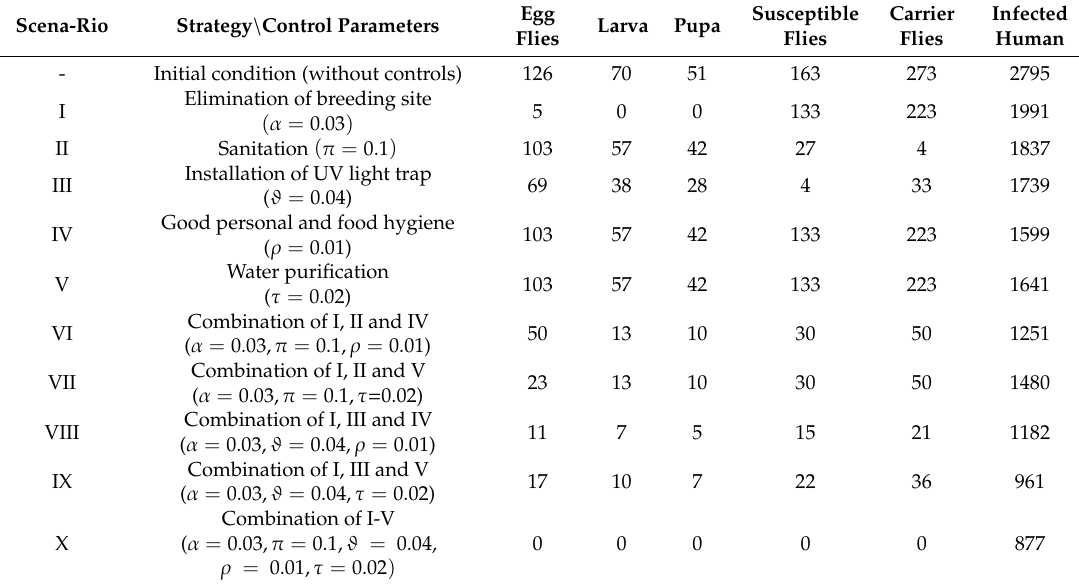
Table 5. Scenarios with combinations of control